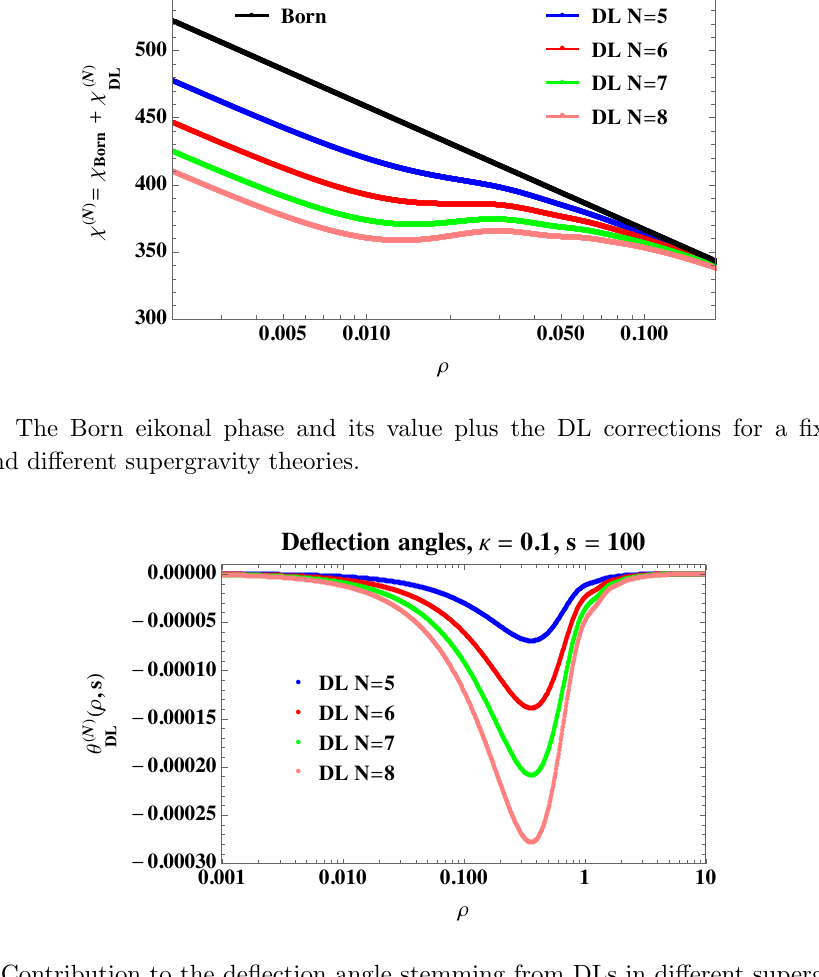
Figure 11 . Contribution to the de(cid:13)ection angle stemming from DLs in di(cid:11)erent supergravities as a function of the impact parameter (cid:26) with (cid:20) = 0 : 1 and s =